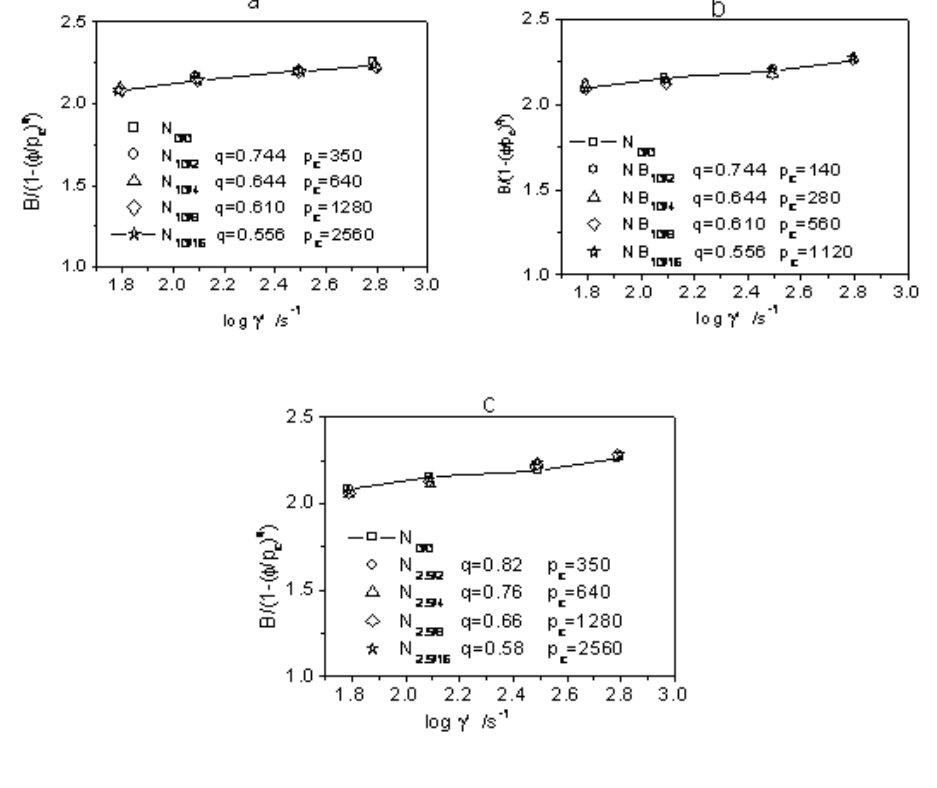
Figure 8. Die swell vs. apparent shear rate plots for EB-cross-linked NR latex gel-filled raw NR for gels irradiated: (a) without a sensitizer at 10kGy; (b) without a sensitizer at 2.5kGy; and (c) with a butyl acrylate sensitizer at 10kGy,